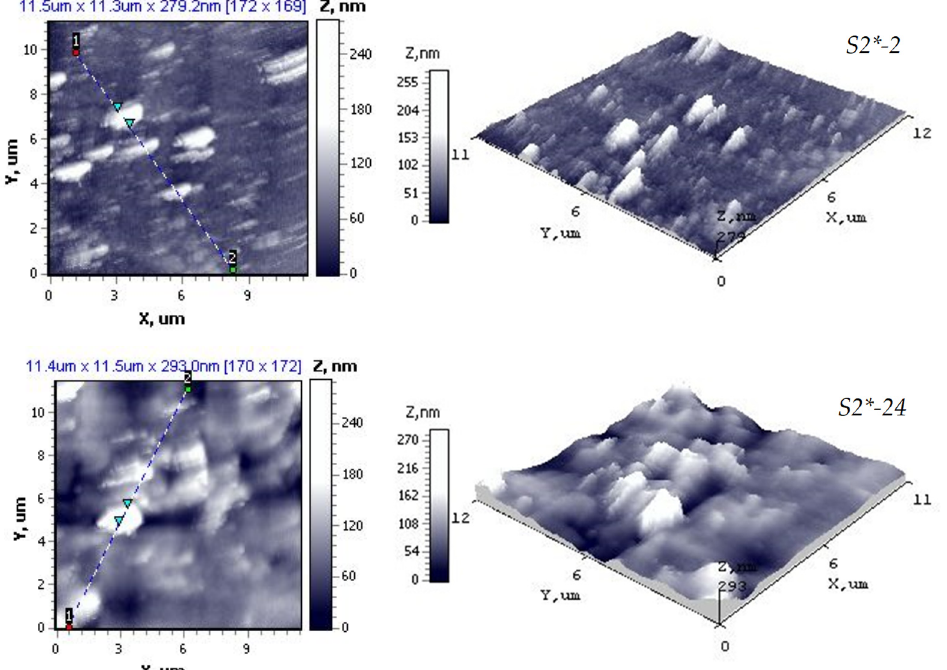
Figure 8. AFM images of cadmium chalcogenide layers on PA 6. Table 7. Surface roughness parameters of cadmium chalcogenide layers chalcogenized in 0.1 mol/L solution of H 2 TeS 4 O 6 at 25 ºC.